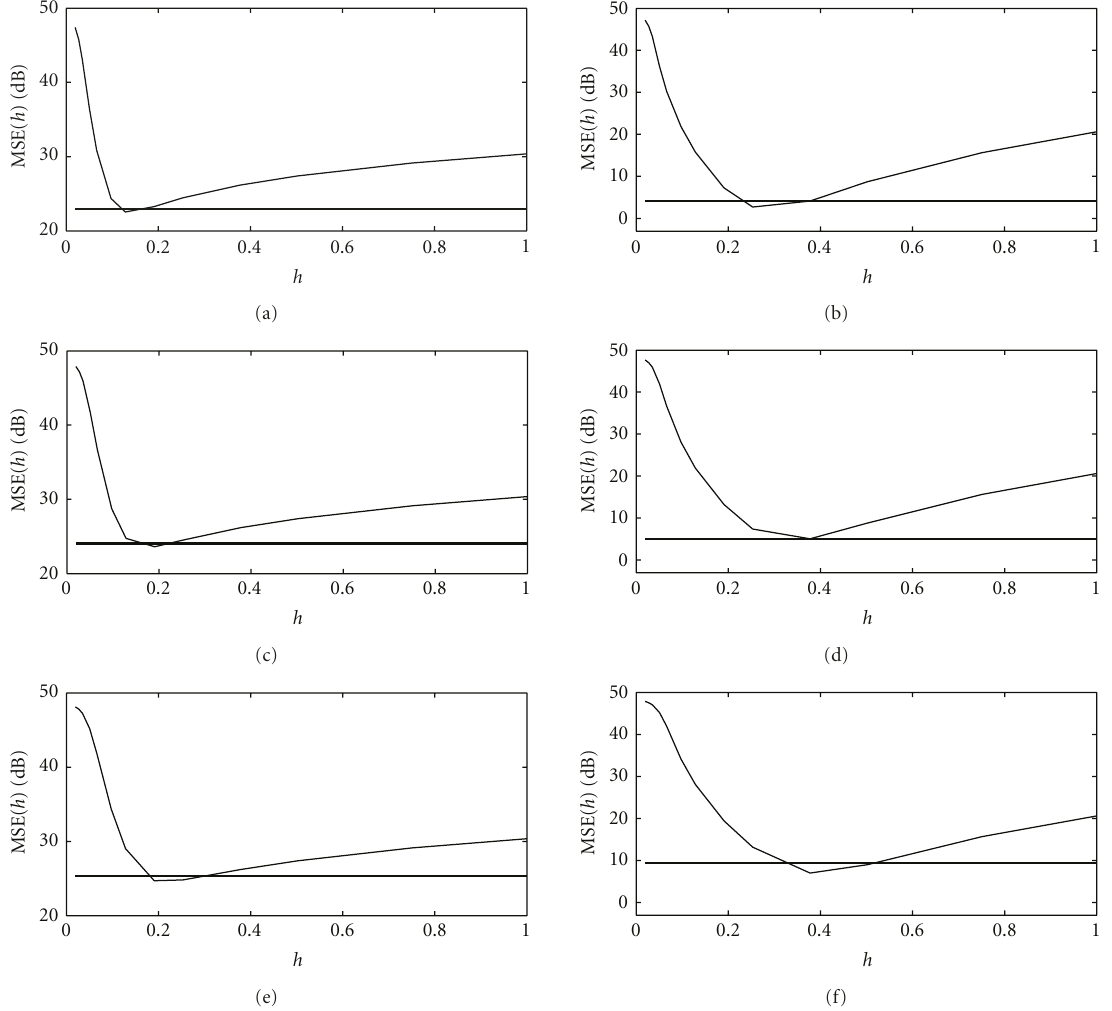
Figure 1: MSE for the chirp-rate estimation: (a) signal 1, σ = 0 . 06; (b) signal 2, σ = 0 . 06; (c) signal 1, σ = 0 . 09; (d) signal 2, σ = 0 . 09; (e) signal 1, σ = 0 . 12; (f) signal 2, σ = 0 . 12, Thin line - fixed window estimator; thick line adaptive window